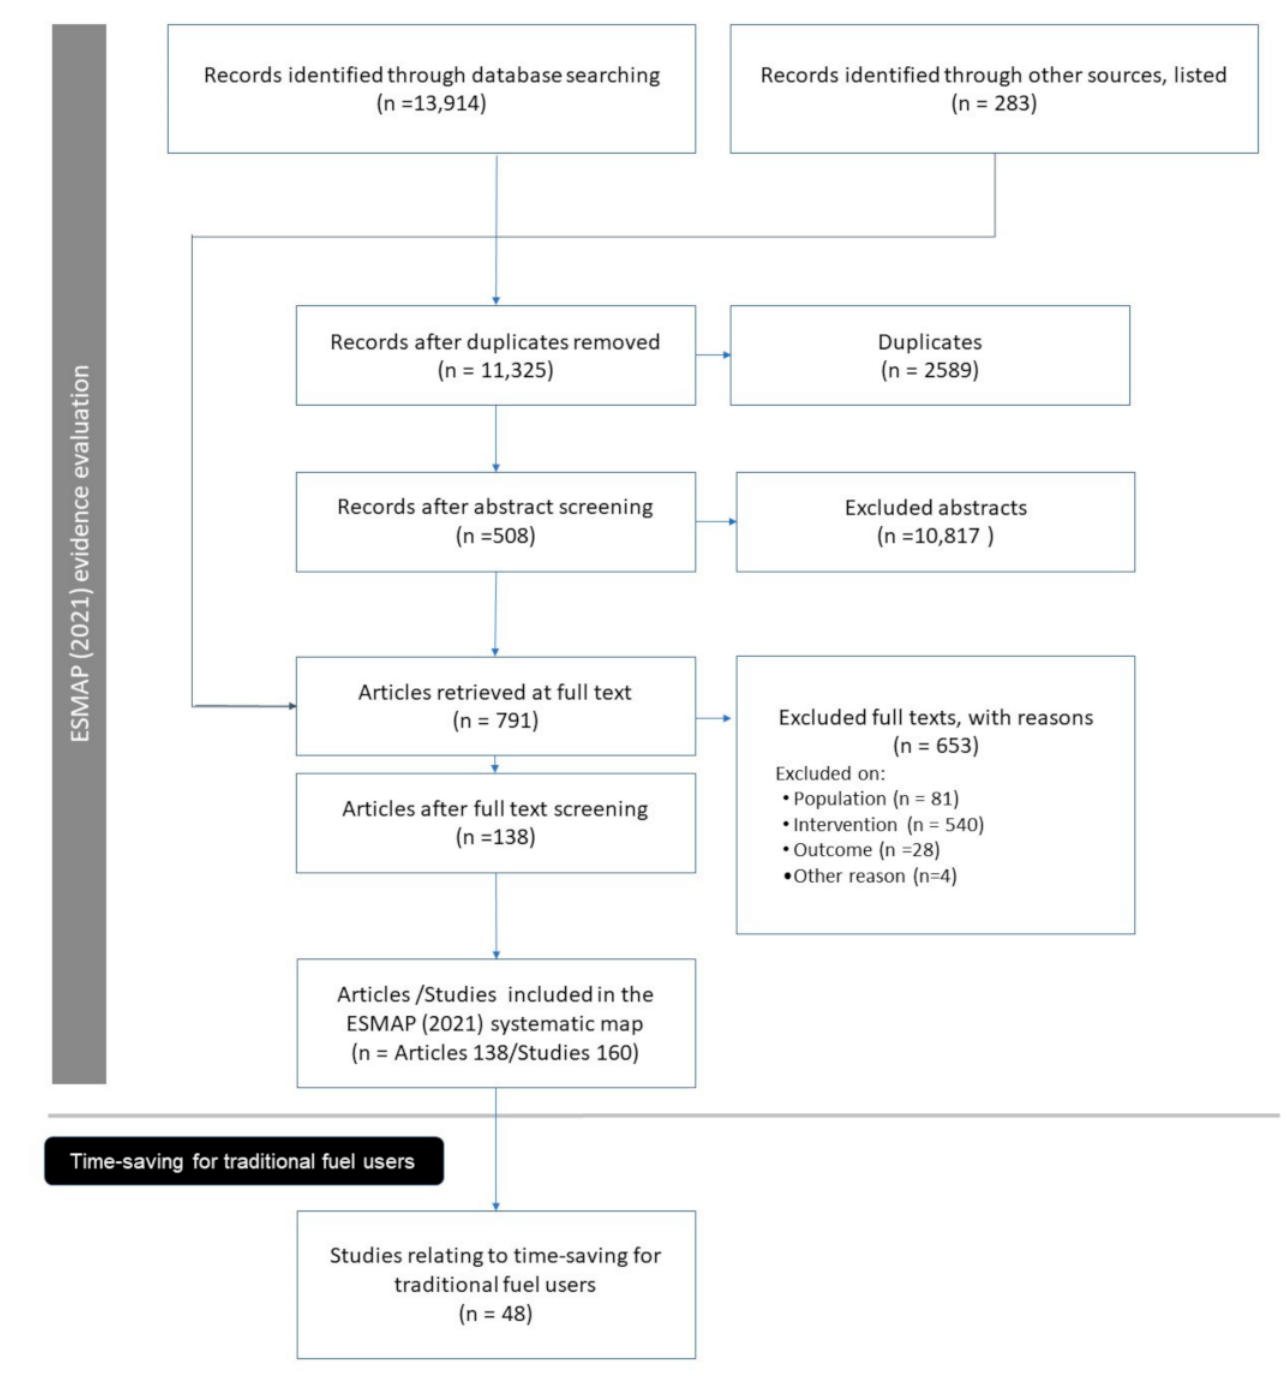
Figure 2. A flow chart of studies included in the systematic map. Adapted from Haddaway et al. (2017)